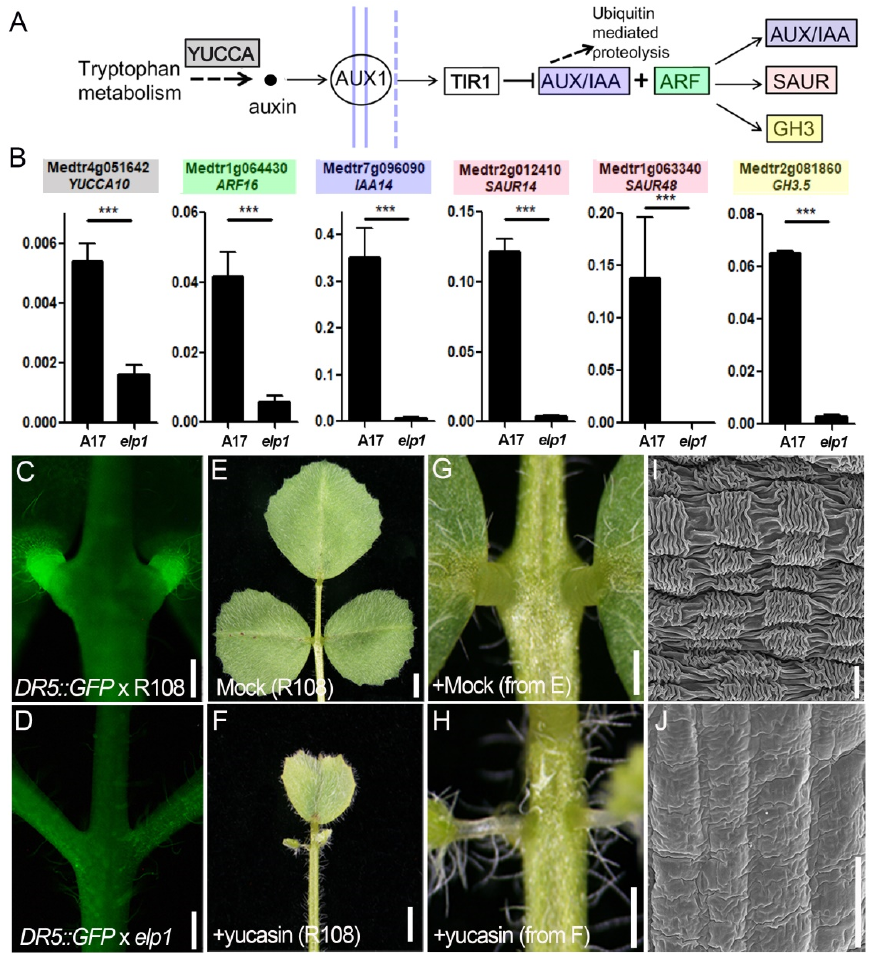
Figure 6. The auxin pathway is involved in the ELP1 regulated pulvinus development. ( A ) Diagram of auxin biosynthesis and signaling pathway-related genes. The colored genes are corresponding to the genes listed in figure ( B ) with same color, respectively. ( B ) RT-qPCR of auxin related genes transcription in pulvinus of WT and the equivalent position of elp1 mutants. Values shown in the form mean ± SD ( n = 3), and asterisks indicate a statistically significant difference between WT and elp1 (***, p < 0.001; t -test). ( C , D ) GFP signal in DR5::GFP transgenic lines of WT ( C ) and elp1 mutants ( D ). GFP signals are significantly detected in pulvinus of WT but not in elp1 mutants. ( E , F ) M. truncatula wild-type (R108) plants treated without ( E ) or with 250 µ M yucasin ( F ), a specific chemical inhibitor of YUCCA protein, for 4 weeks were photographed. ( G , H ) Partially magnified view of pulvinus corresponding to ( D , E ), respectively. ( I , J ) Scanning electron microscope images of a pulvinus corresponding to ( G , H ), respectively. Scale bars: ( C – F ) 0.5 mm; ( G , H ) 2 mm, ( I , J ) 10 µ